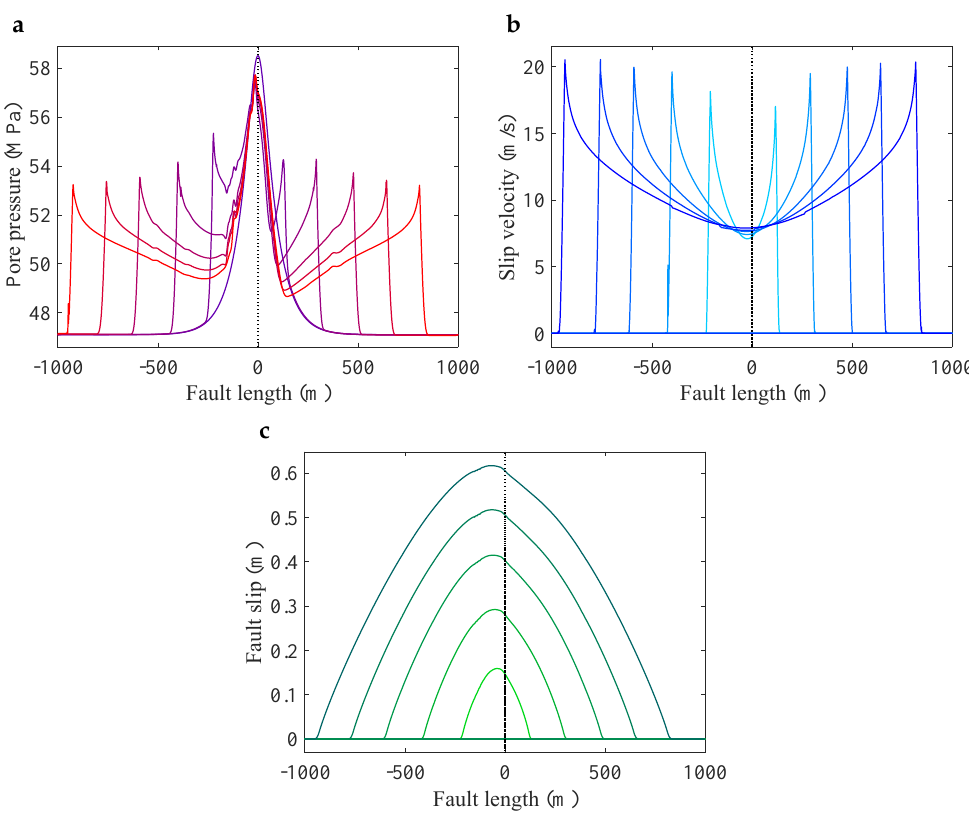
Figure 4. Results of the seismic rupture for the Basel EGS reservoir. We show the results for the injection protocol registered in 2006 (Figure 4b). In panel ( a ), we represent the evolution of the pore pressure along the fault during the rupture. The fronts of undrained pressures spread to both sides of the fault almost symmetrically. In panel ( b ), we show the results of the slip velocity for the same time steps. In panel ( c ), we plot the results of the relative slip between the walls of the fault at the same time steps. We compute the seismic moment and estimate the earthquake magnitude with the relative slip between the walls of the